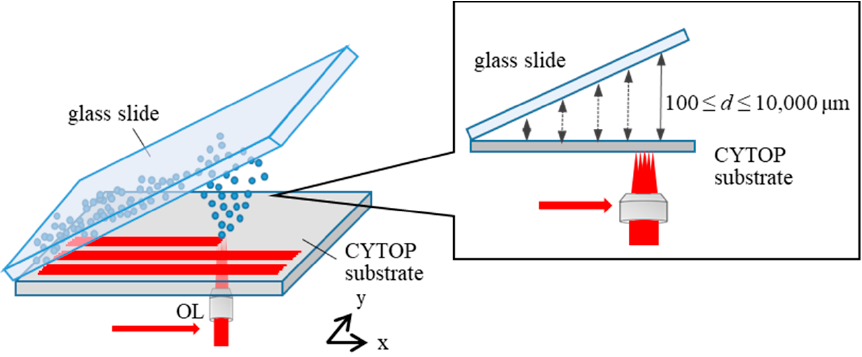
Figure 2. Schematic of the NP deposition process at various CYTOP–glass distances.